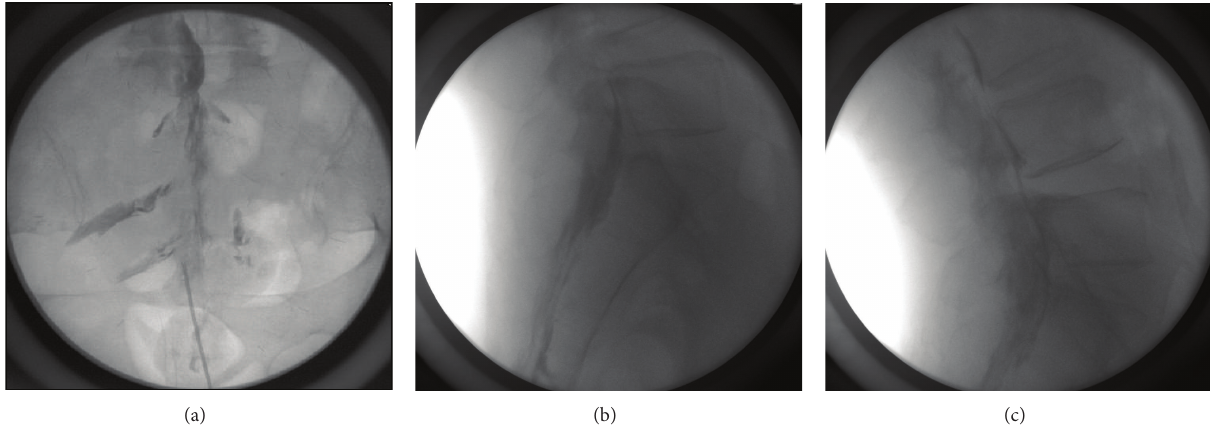
Figure 2: Sample image of the epidural spreading pattern after injection of 4mL of contrast media using the left side needle tip position ((a) anteroposterior view; (b) lateral view) and (c) after injection of 14mL of injectates.